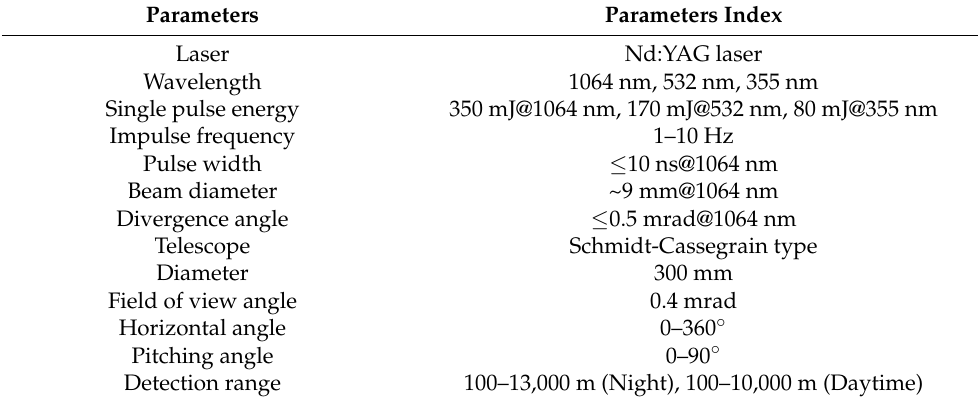
Table 1. System parameters of the Mie-scattering lidar.